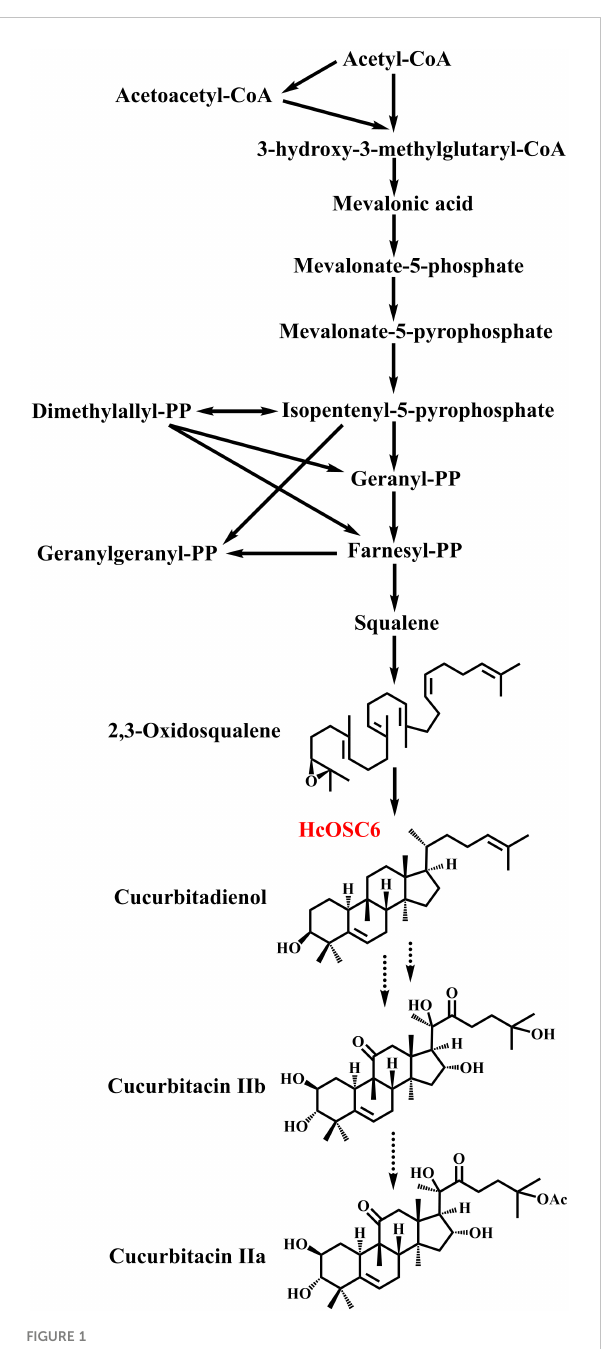
FIGURE 1 The biosynthetic pathway of cucurbitacins in H.